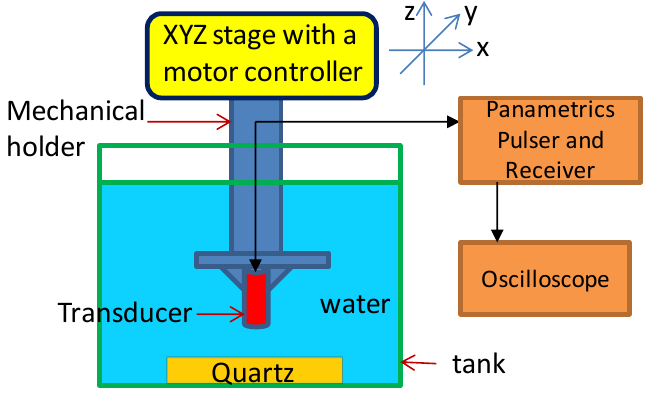
Figure 8. Illustration of the pulse-echo experimental setup.